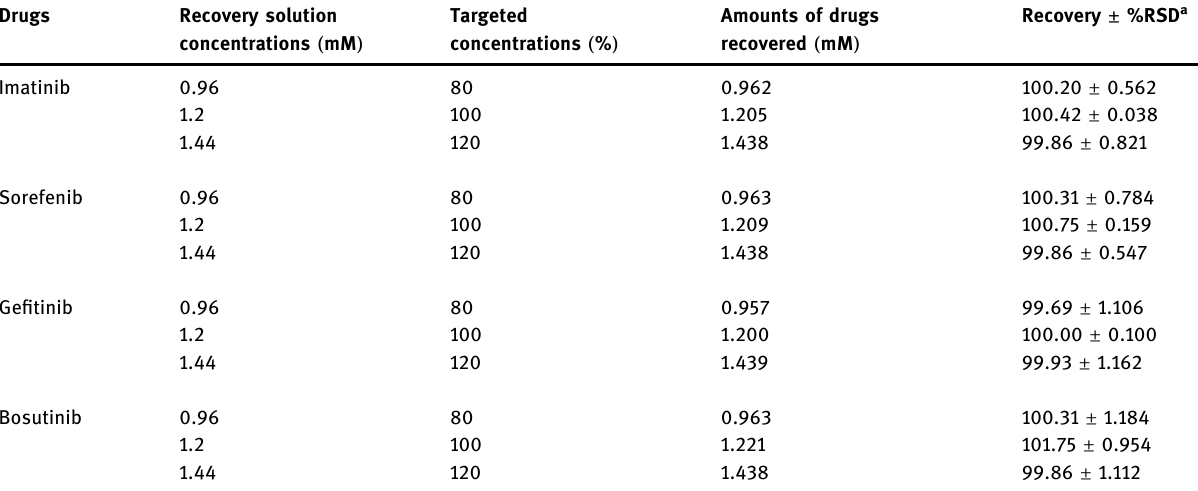
Table 4: Recovery results of imatinib, sorafenib, ge fi tinib and bosutinib in their dosage forms prepared in - house